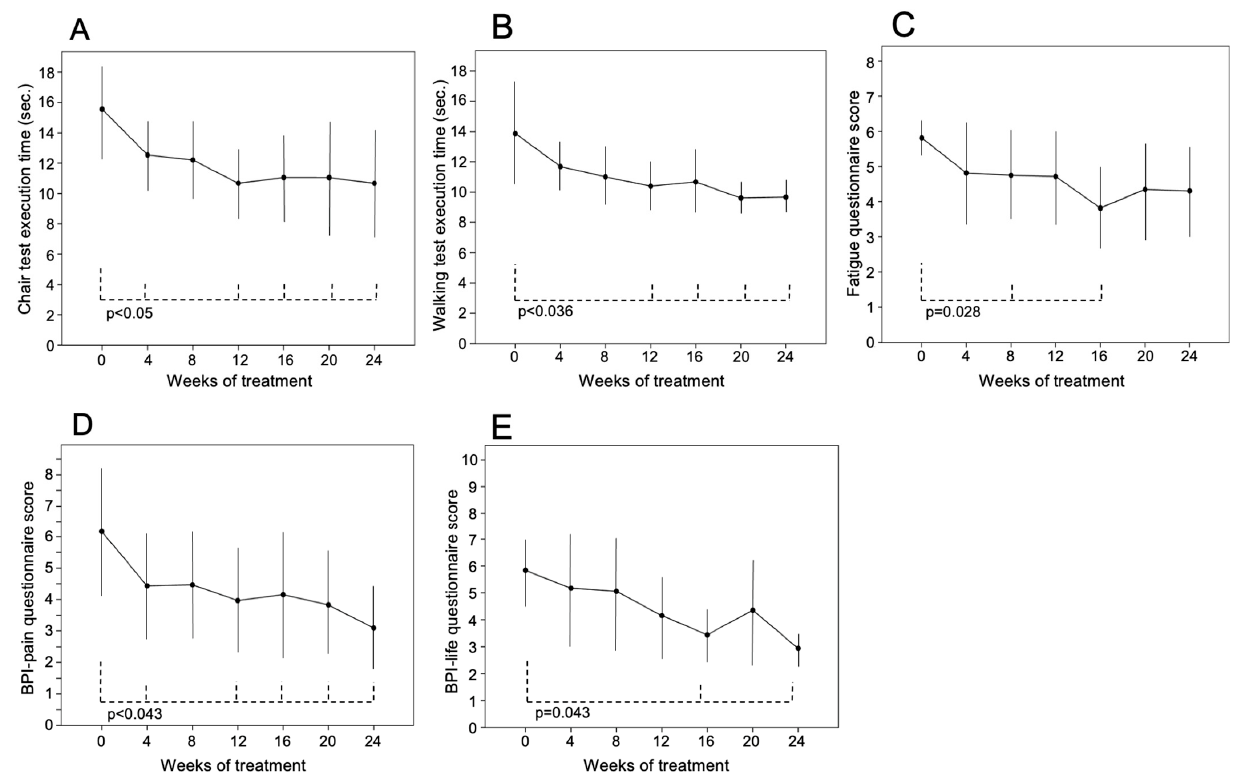
Figure 2. Findings of ( A ) chair and ( B ) walking tests and ( C ) fatigue, ( D ) BPI-pain and ( E ) BPI-life questionnaires during 24 weeks of treatment with burosumab in 8 patients with XLH. Variables are reported as mean ± SD. The drug was injected subcutaneously (1 mg/kg body weight). Physical tests were performed in 8 patients; fatigue, BPI-pain and BPI-life questionnaires were performed in 7 patients.